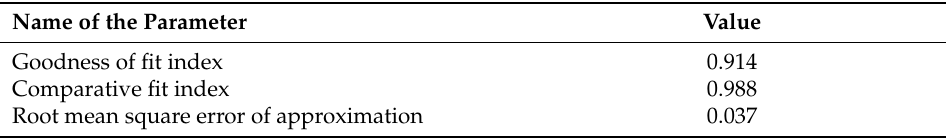
Table 8. Unstandardised regression weights estimations. Table 9. Parameter value for model fit measures with SPSS